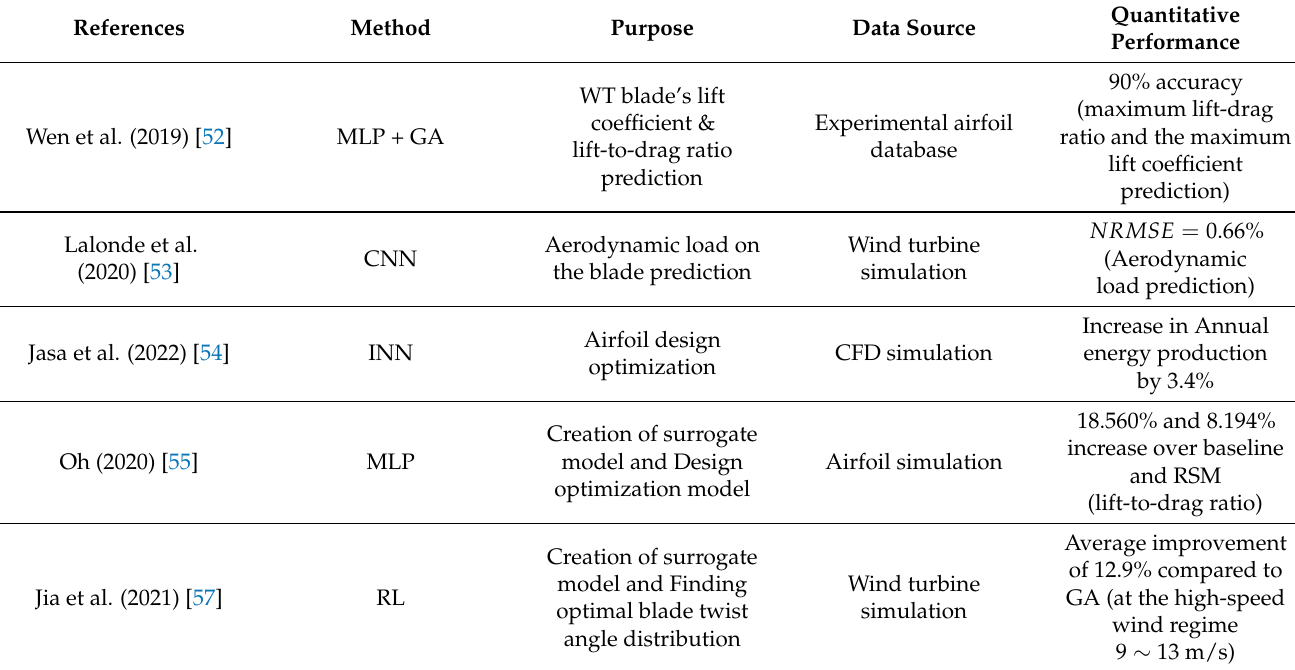
Figure 10. Schematic of an INN architecture. Table 3. NN-based turbine blade design